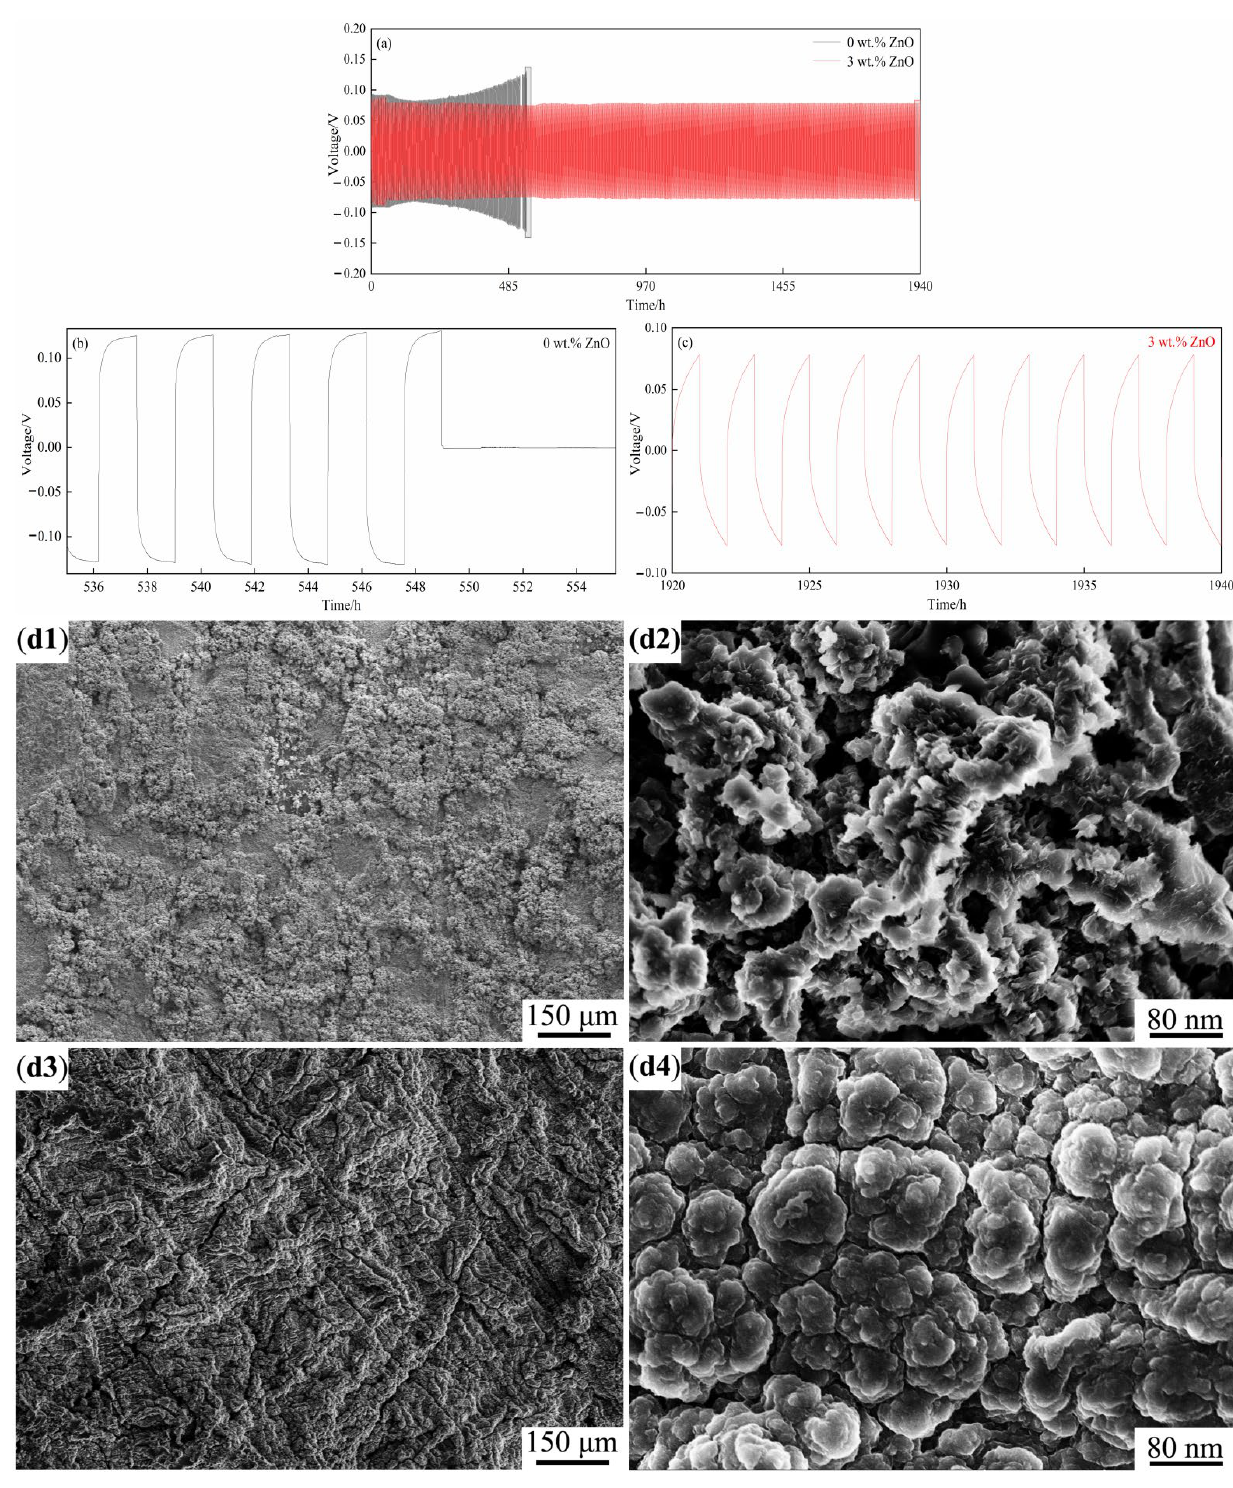
Figure 6. Voltage curves of lithium intercalation/deintercalation of Li/SPEs/Li coin cells at 60 °C. ( a ) the complete curves (0 wt.% ZnO [26], 3 wt.% ZnO), ( b , c ) locally magnified curves for 0 wt.% ZnO [26] and 3 wt.% ZnO, respectively, and the SEM images of lithium dendrites on the lithium sheets after charge and discharge. ( d1 , d2 ) Zero wt.% ZnO [26], ( d3 , d4 ) 3 wt.% ZnO.